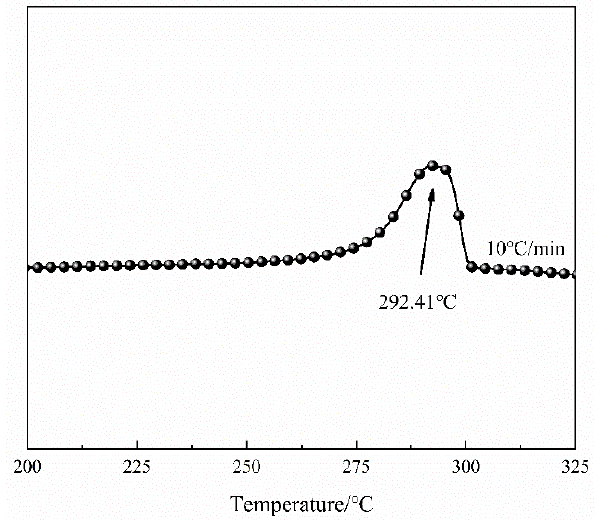
Figure 2. DSC heating scan pattern of polyphenylene sulphide.